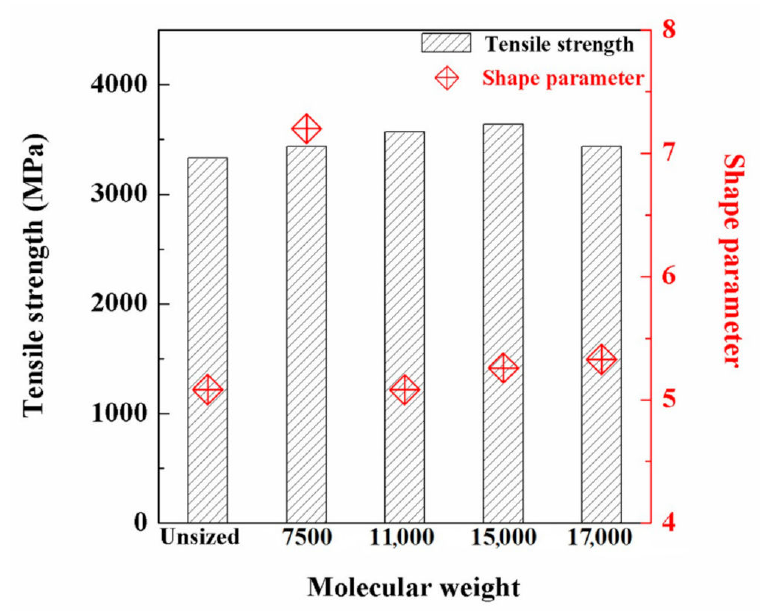
Figure 12. Shape parameter and tensile strength of unsized CFs and sized CFs by emulsions with the four di ff erent molecular